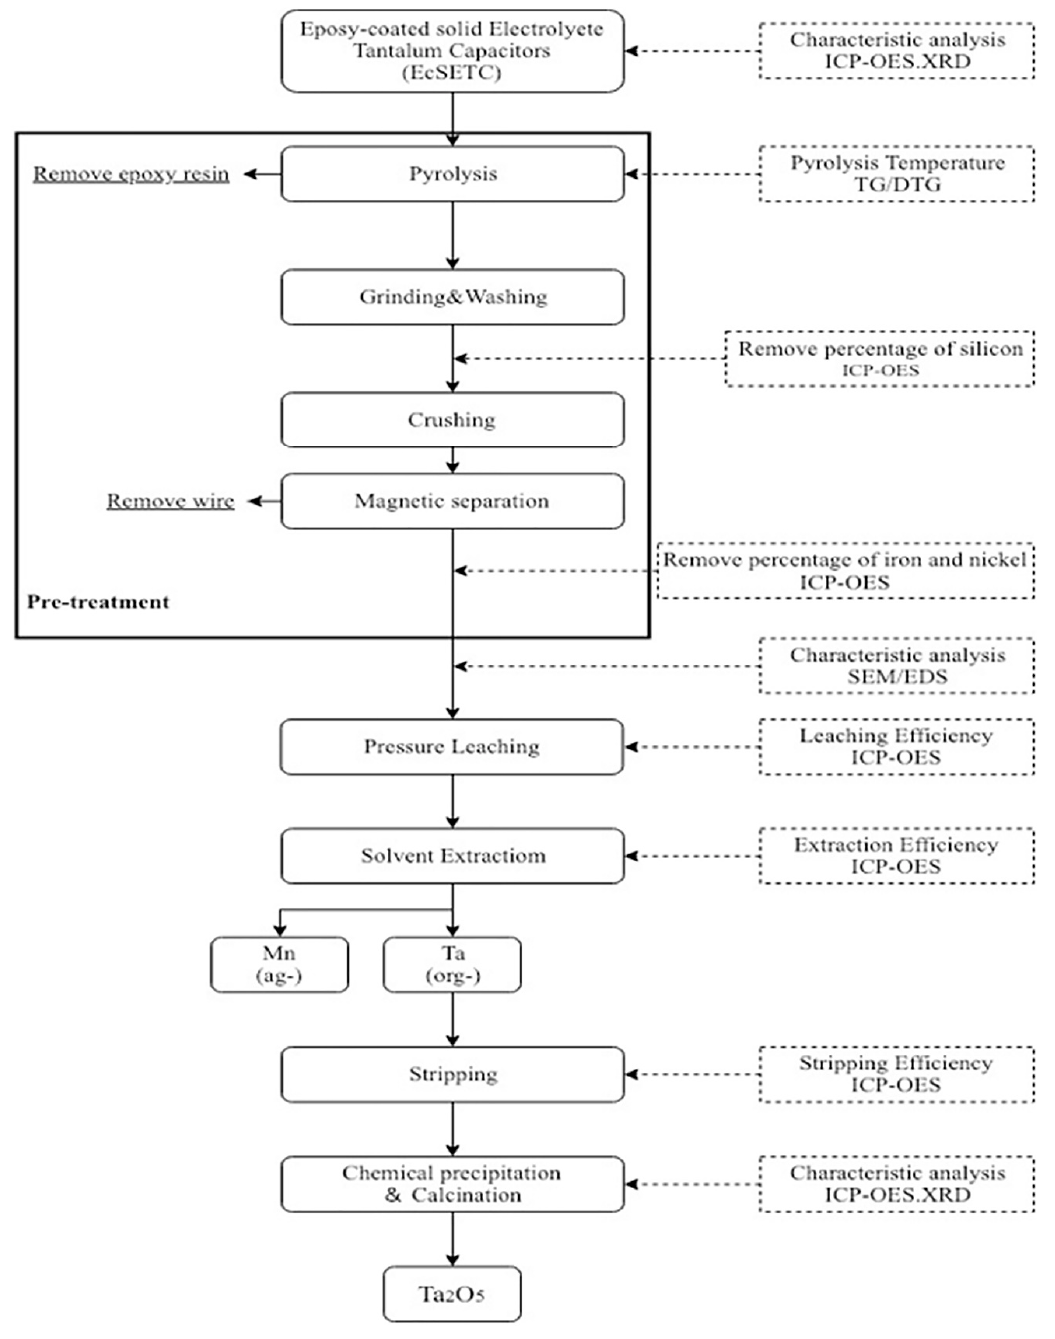
Figure 1. The proposed tantalum recovery process from EcSETCs. ICP-OES: inductively coupled plasma optical emission spectrometry; SEM: scanning electron microscopy; EDS: energy dispersive X-ray spectrometry; TG/DTG: Thermogravimetric analysis.